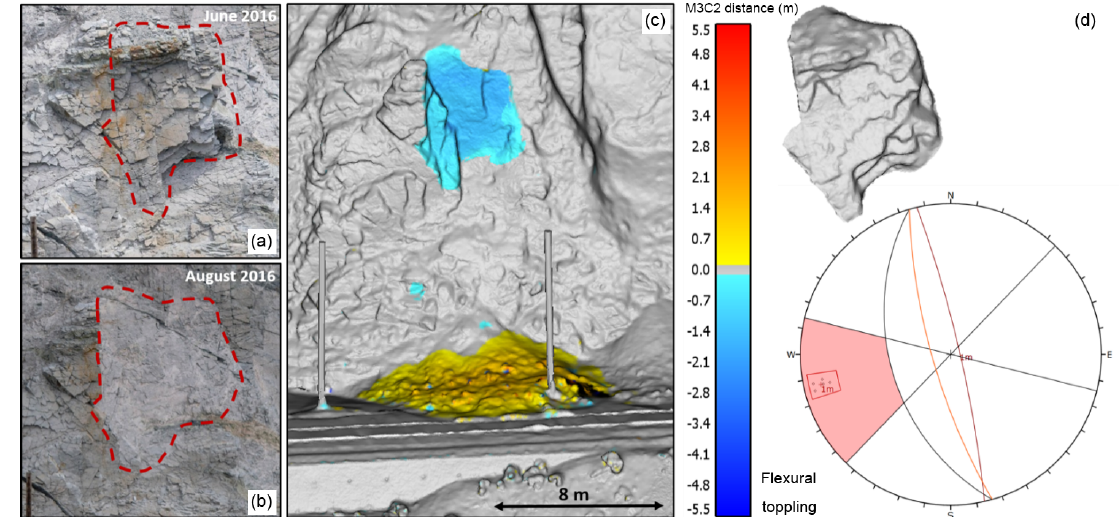
Figure 5. Site C. Visual overview of the 32m 3 flexural toppling event detected at the White Canyon East site between June and August 2016. The event involved a large slab of weathered and heavily jointed rock mass which failed approximately 14m above track level. Site photos (a, b) of the source zone pre- and post-failure are shown. Change detection results of the event are shown (c) with cool colours indicating material loss and warm colours indicating material accumulation. Change detection results indicate the bulk of material from the rockfall event was retained in the track-side ditch. The rockfall hull of the event extracted from the pre- and post-failure meshes is shown (d) , as well as a stereonet representation of the flexural toppling failure mode. It should be noted that parts of the source rock mass also exhibited overhanging sections.